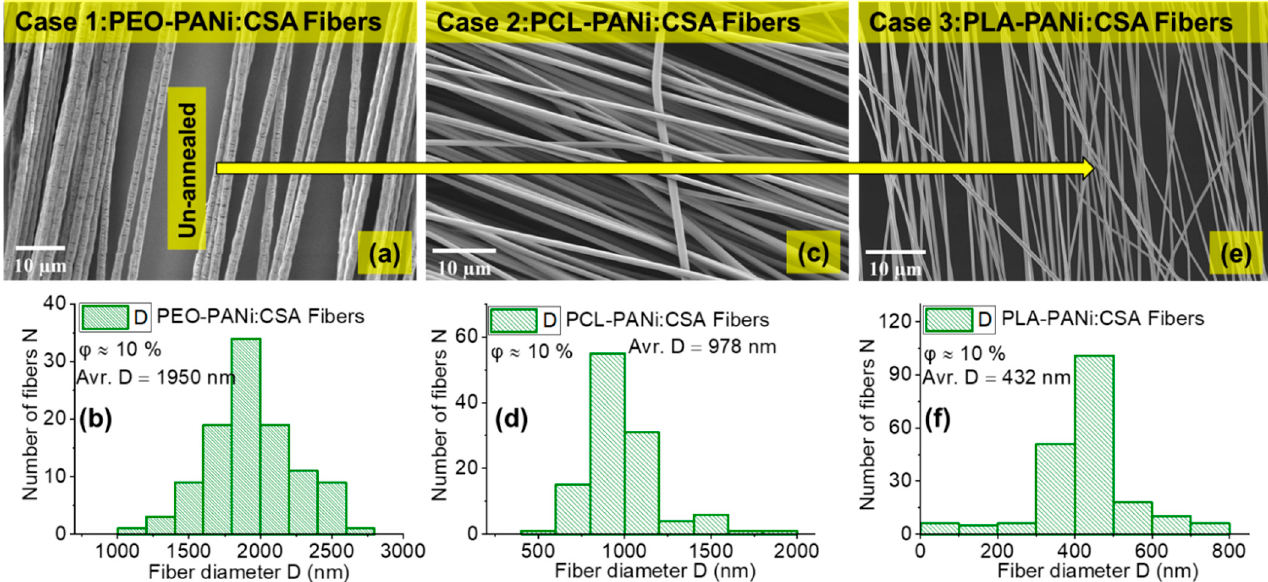
Figure 2. SEM images with their fiber-diameter histograms for Case 1: PEO-PANi:CSA fibers (panels a , b ), Case 2: PCL- PANi:CSA fibers (panels c , d ), and Case 3: PLA-PANi:CSA fibers (panels e , f ), respectively. The concentration of filler PANi ( φ PANi ≈ 10%) is the same for all cases, and all fibers are un-annealed.